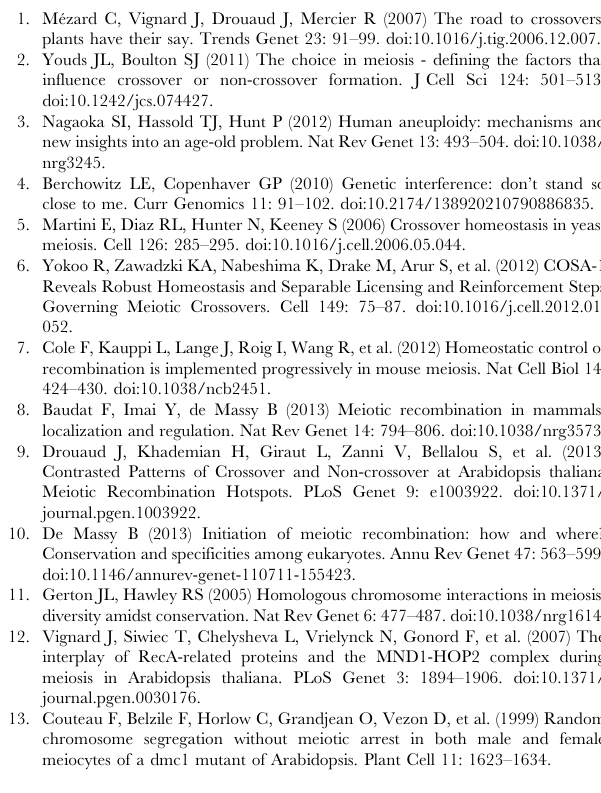
Figure S4 Immunolocalization of HEI10 at diakinesis. Immu- nolocalization of HEI10 at diakinesis is shown (A) in wild type and (B) in Atpss1-1 . (C, D) Scatter plot of HEI10 foci number per cell at diplotene and diakinesis. (E) Distribution of chromosomes according to their HEI10 foci number at diakinesis. Cells were prepared according to Chelysheva et al. [47]. Scale bar =10 m m. Figure S5 AtPSS1 and AtWIP1 interact in BiFC. Nicotiana benthamiana cells were infiltrated with different combinations of split YFP fusions with AtPSS1 and AtWIP1. (A) Co-expression of BiFC constructs YFP N -AtWIP1 and YFP C -AtPSS1 gave a clear cytoplasmic YFP fluorescence signal, revealing interaction be- tween AtWIP1 and AtPSS1. (B, C) Negative controls correspond to co-expression of YFP C -AtPSS1 with the unrelated YFP N - GLOBOSA protein or YFP N -AtWIP1 with the unrelated YFP C - DEFICIENS protein. (D) Positive control corresponds to co- expression of YFP N -GLOBOSA with the YFP C -DEFICIENS protein. Scale bar= 50 m m. Table S1 Tetrad analysis. (A) Tetrad raw data set. The FTL system relies on transgenic markers conferring cyan, yellow or red fluorescence of pollen grains within tetrads. Drawings above each column represent the different distribution possibilities of markers among the four chromatids and the corresponding distribution of colors in the tetrad, according to the nomenclature of Berchowitz and Copenhaver [46]. For each pair of intervals (e.g. I1b and I1c are two adjacent intervals on chromosome 1) and each genotype the observed number of each type of tetrad is given. (B)